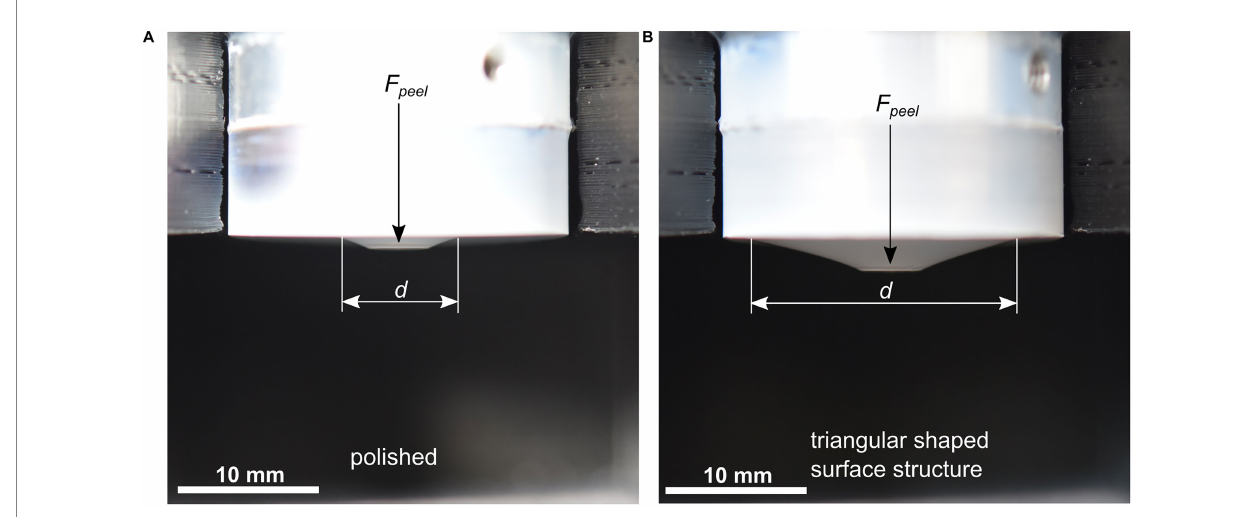
FIGURE 6 Peel-off force measurement of a polished (flat) control sample (A) and a triangular surface-structured Ti alloy sample (B) . The applied weights and therefore also the normal forces are equal in both panels. One can see that the cone diameter d at equal applied forces is larger on the triangular surface-structured specimen than on the polished (flat) control specimen, which indicates that the peel-off force per unit length is smaller for the surface-structured sample.